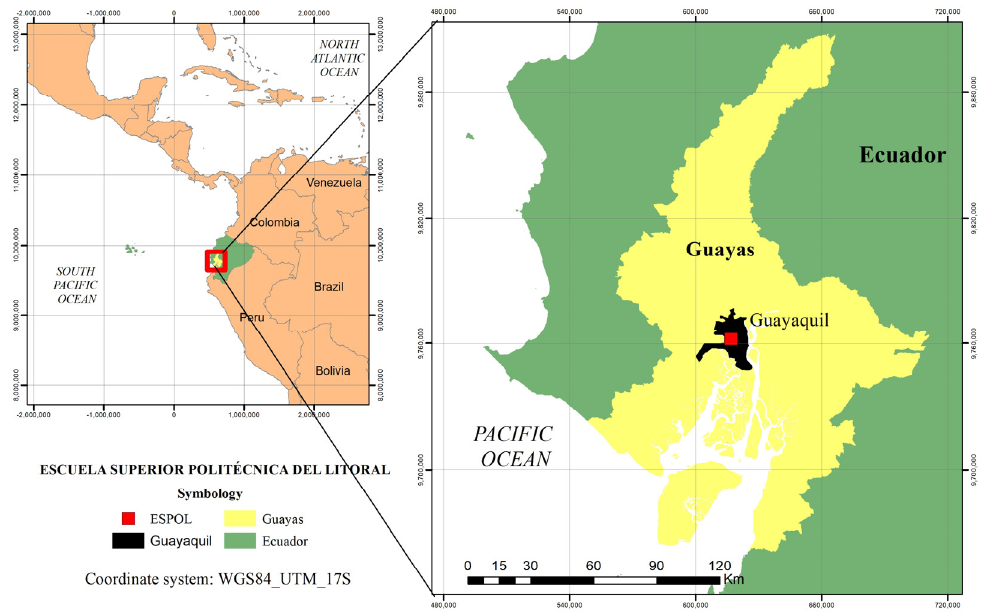
Figure 1. Geographical location of the ESPOL university campus.